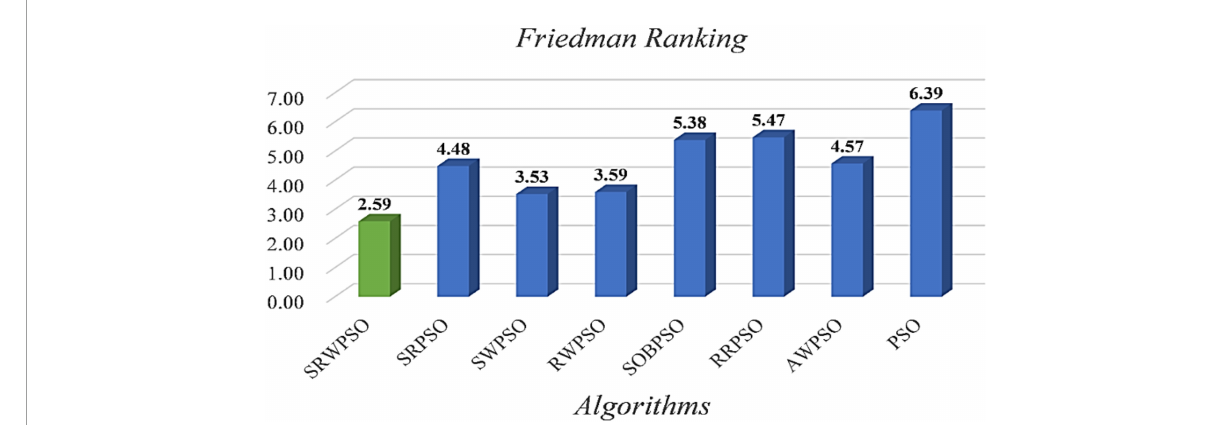
FIGURE4 The results of the Friedman test of different versions.